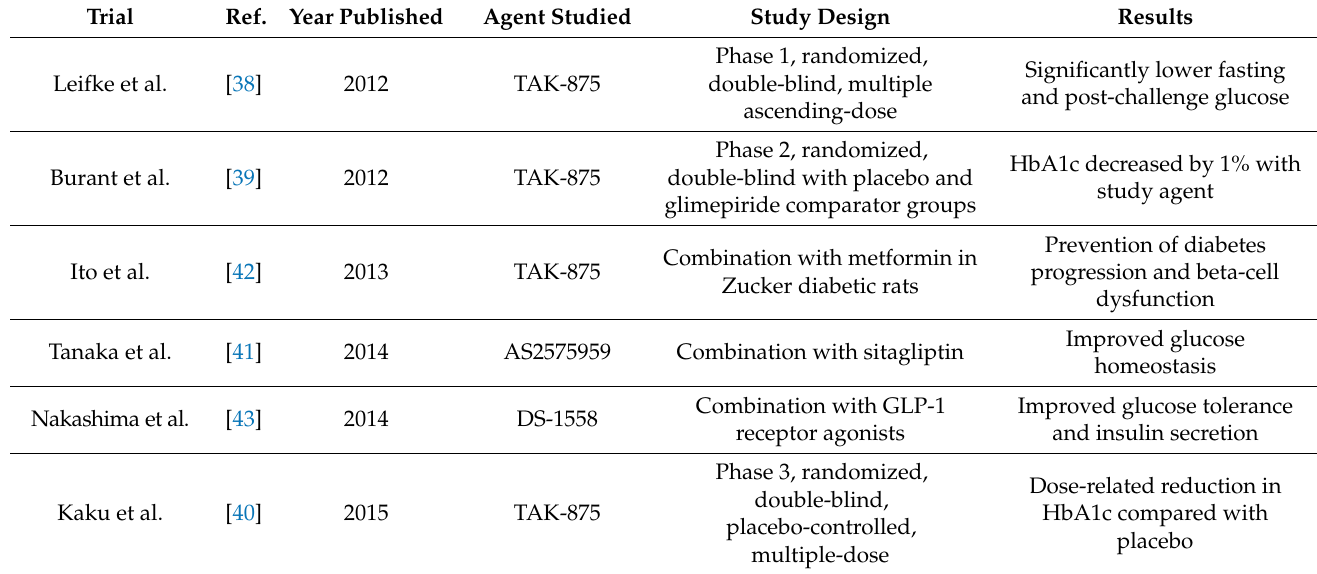
FFAR: Free Fatty Acid Receptor, GLP-1: Glucagon-Like Peptide-1, HbA1c: Hemoglobin